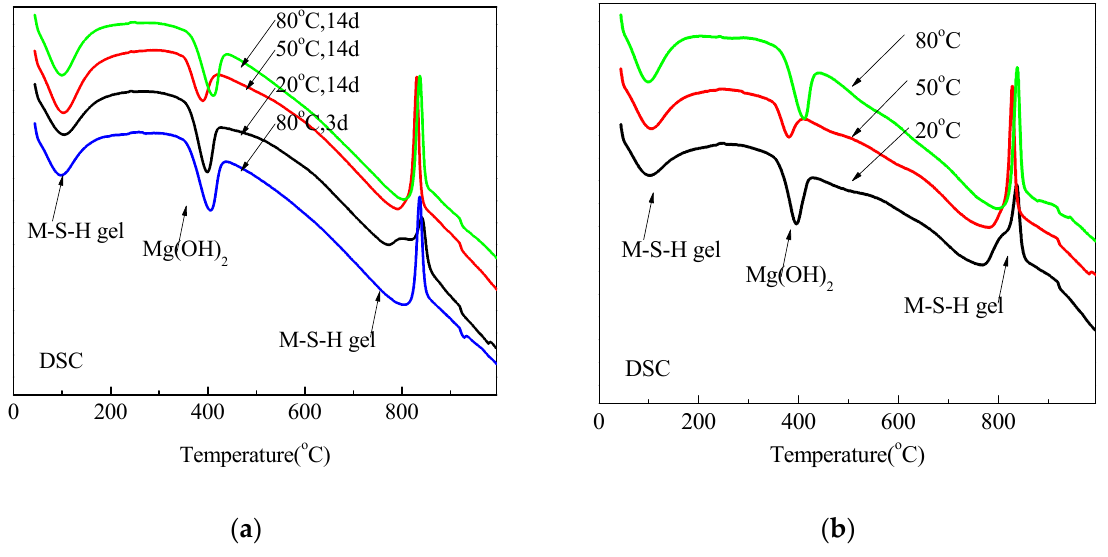
Figure 10. DSC curve of MgO-SF pastes using MgO calcined at 1450 °C for 30 min: ( a ) cured for 3 d and 14 d and ( b ) cured for 28 d.